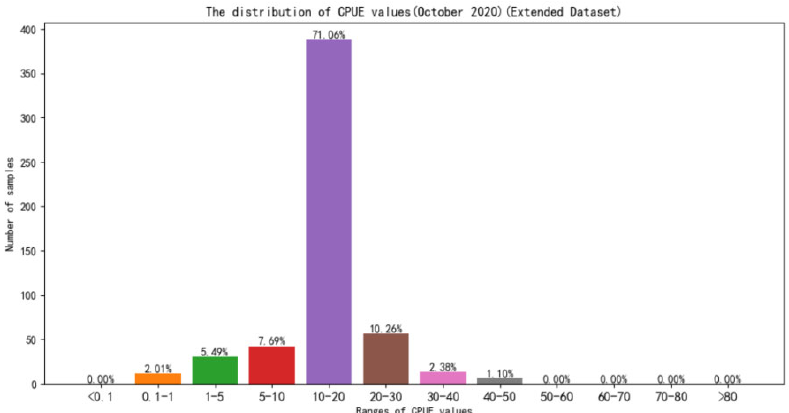
Figure 14. The distribution of CPUE values of samples in test datasets in October 2020.